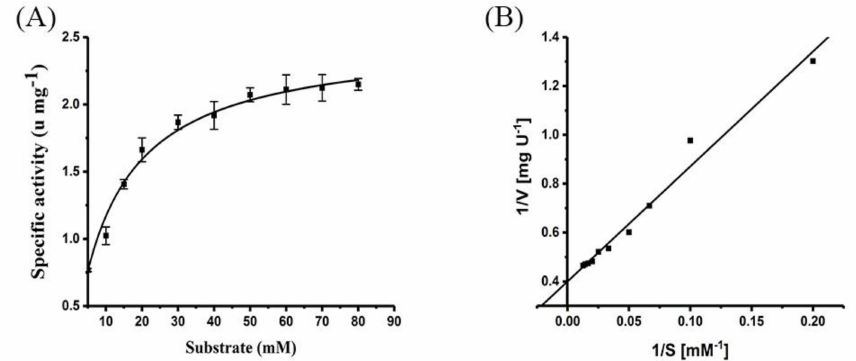
Figure 3. Determination of kinetic parameters of XcAS-catalyzed transglucoside reaction: ( A ) Michaelis–Menten plot and ( B ) double-reciprocal plot. Reactions were carried out at pH 7.0 and 30 ◦ C by adding various amount of sucrose and hydroquinone (HQ) (ratio 10:1) to 50 mM sodium phosphate